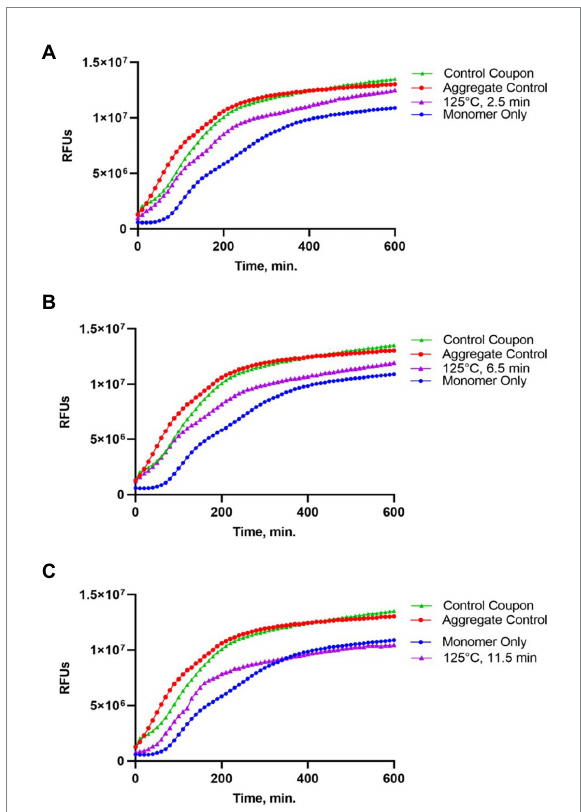
FIGURE 2 Impact of the 125 ° C treatment on the seeding activity of Sup35NM-His 6 aggregates. Sup35NM-His 6 , recovered from coupons treated at 125 ° C for 2.5 min (A) , 6.5 min (B) and 11.5 min (C) was analyzed. The protein recovered from coupons (purple, empty triangles) was added to soluble Sup35NM-His 6 , monomers at 1:20 ratio according to Bradford. Unseeded monomer (blue, filled circles), and monomers seeded by in vitro obtained aggregates that were been immobilized on coupons (red, empty circles), or were recovered from untreated control coupons (green, filled triangles) were used for the comparison. Seeding activity is always detected after 125 ° C treatment, even though it is less efficient than by control aggregates. Typical examples are